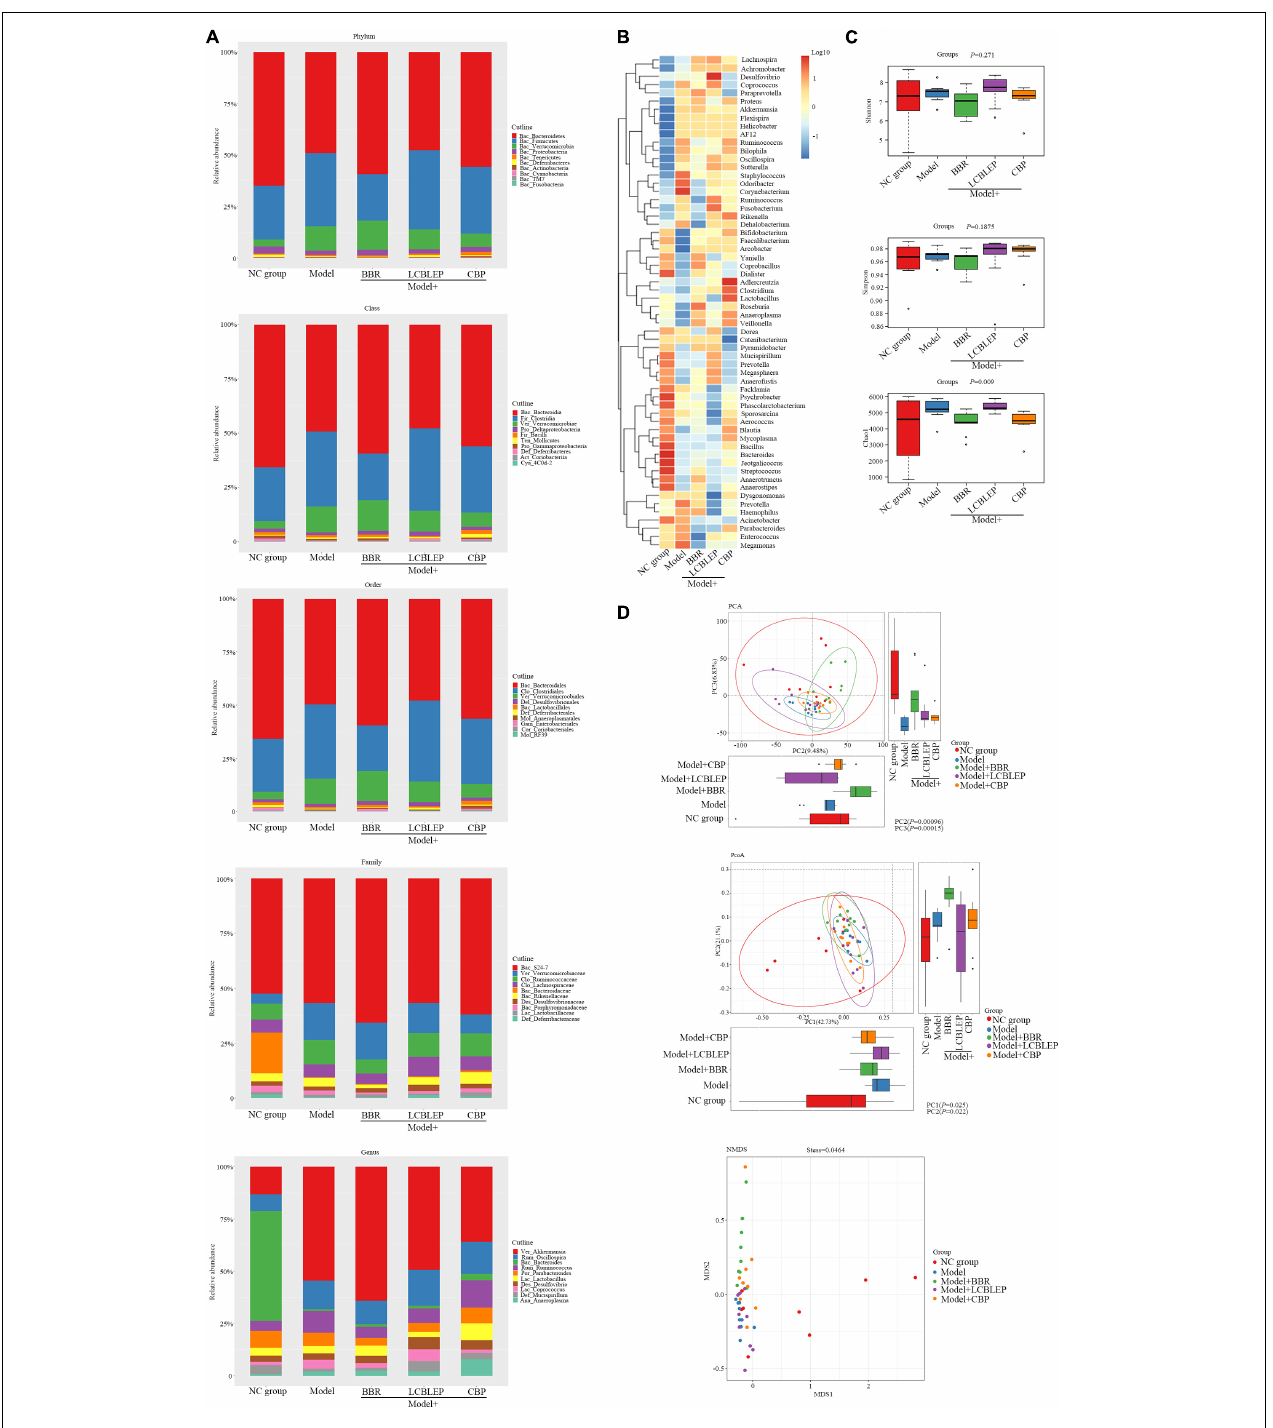
FIGURE 2 | (A) Histograms of relative abundance of species composition at phylum, class, order, family, and genus level, respectively. (B) Clustering heat maps based on genus level were performed to reveal the similarity between samples and the similarity of community composition at the genus level. (C) Box diagram of alpha diversity was analyzed through assessing the species richness and community diversity of the microbiome by Shannon, Simpson, and Chao1. (D) The beta diversity was used to compare the differences between multiple groups of samples by the multivariate statistical method including principal component analysis (PCA), principal coordinate analysis (PCoA), and non-metric multidimensional scaling (NMDS). The horizontal and vertical box diagrams were the distribution of the values of the different groups on the first and the second principal coordinates. Each dot represented a sample, the same color was from the same group, and distance reflected sample